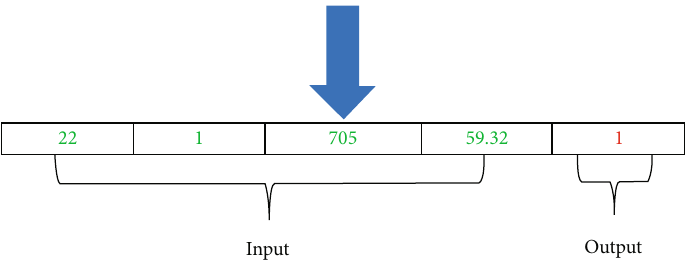
Figure 4: Dataset row after parsing the raw web service log request.